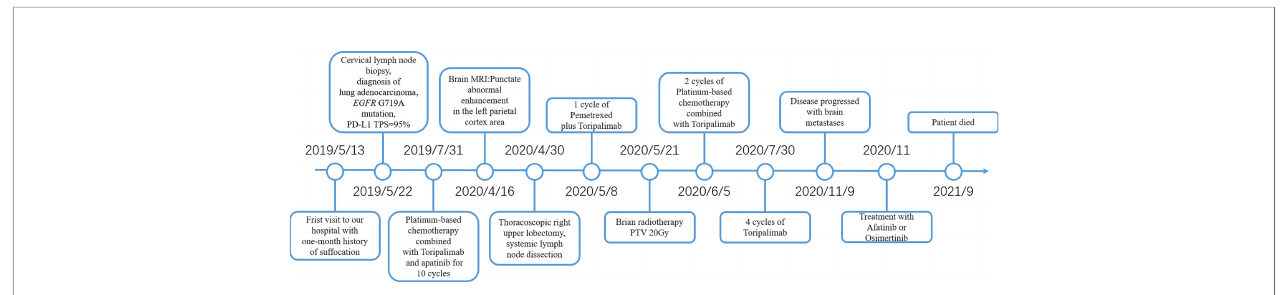
FIGURE 2 | Timeline of diagnosis and treatment in this case. PD-L1, Programmed cell death-ligand 1; TPS, Tumor Proportion Score; MRI, Magnetic resonance imaging; PTV, Planning target